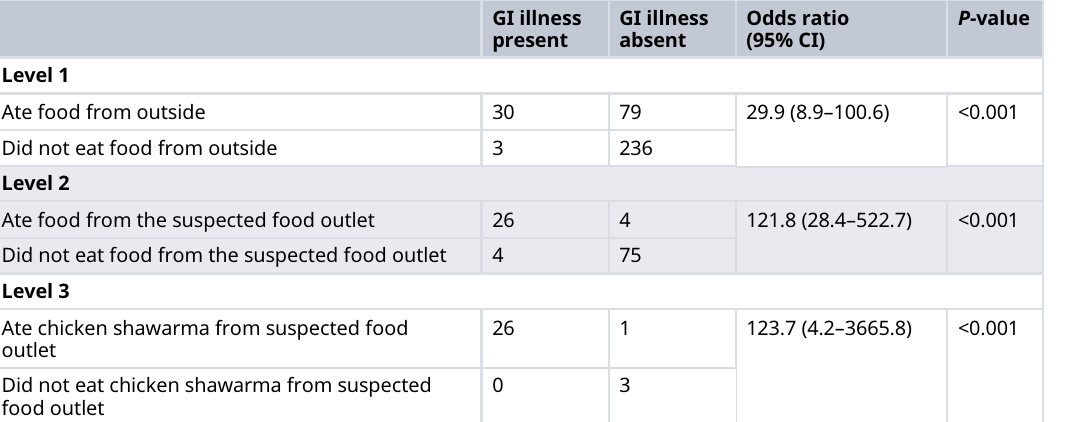
Table 1. Association of gastrointestinal (GI) illness with varying levels of exposure among cases and